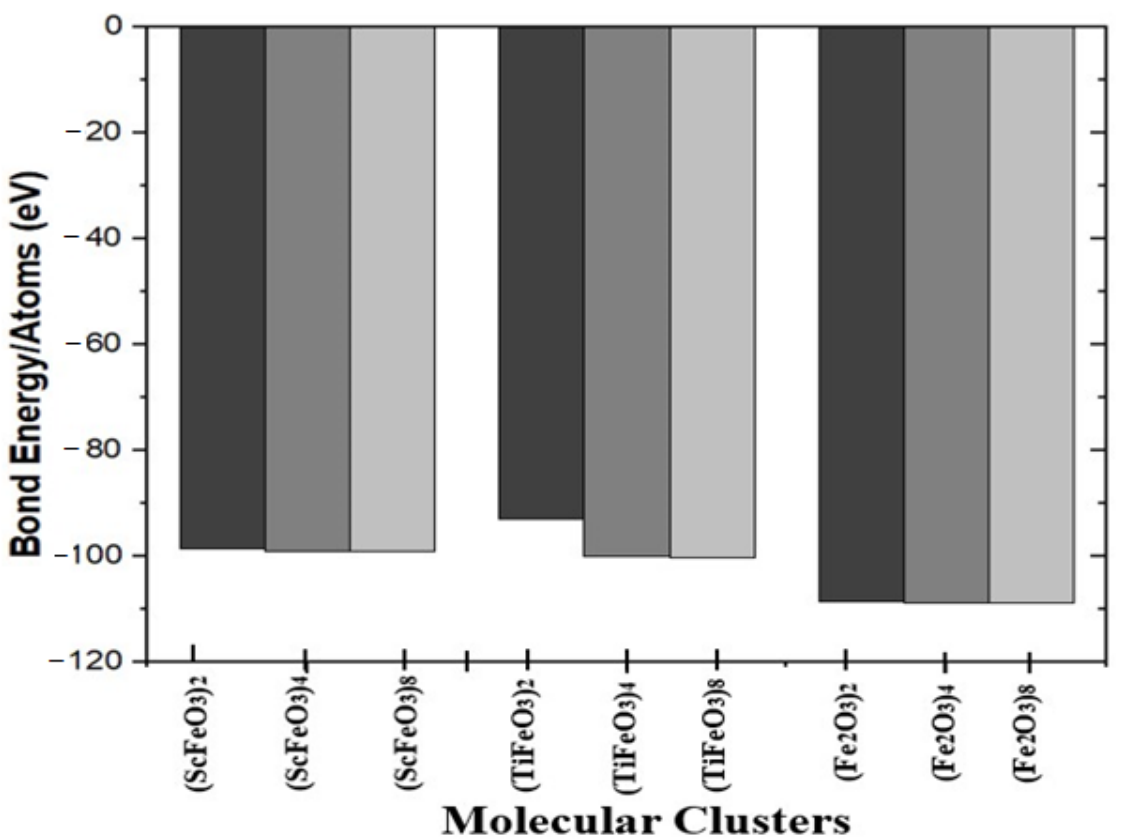
Figure 2. The computed values of bond energy for all molecular clusters of (TMFeO (cid:2871) ) x , where TM = Sc, Ti, Fe and x = 2, 4, 8. TM = Sc, Ti, Fe and x = 2, 4,